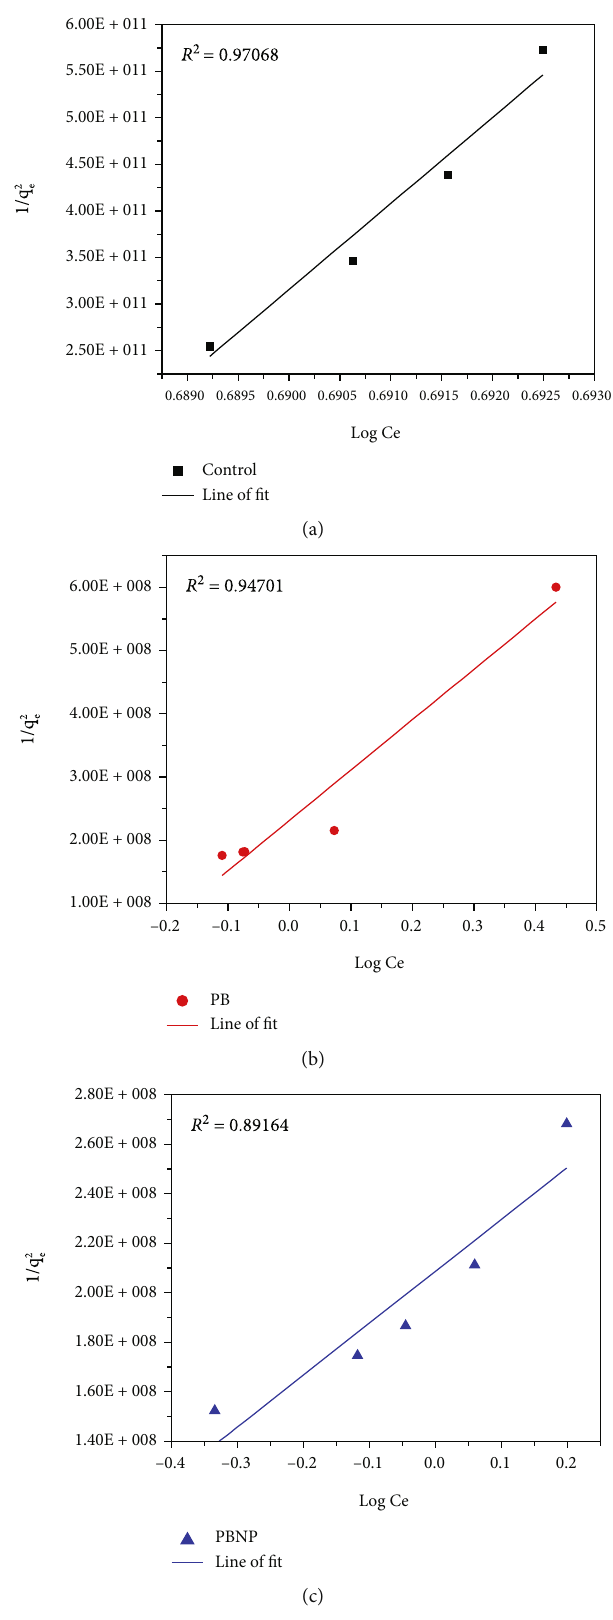
Figure 8: The Harkins-Jura isotherm plot of control (a), PB (b), and PBNP (c)